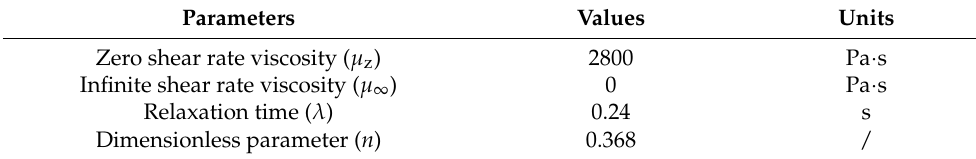
Table 1. Flow properties of PP/Fe 3 O 4 melt at 210 ◦ C. Parameters Values Units Zero shear rate viscosity ( µ z